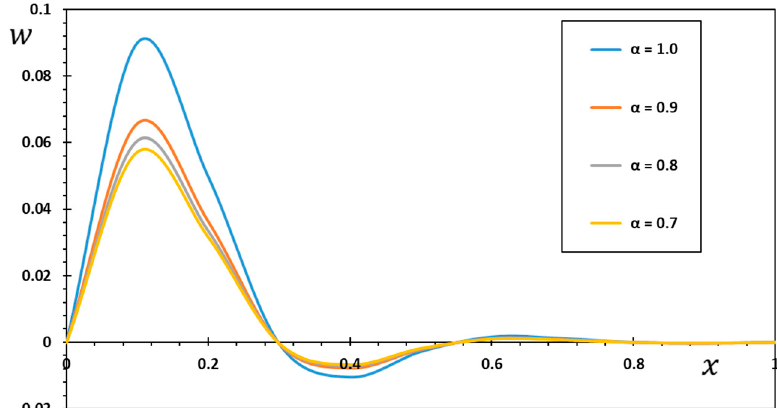
Figure 2. Effect of fractional order, α , on the deflection, w . Figure 3. Effect of fractional order, 𝜶 , on the temperature, 𝜽 .